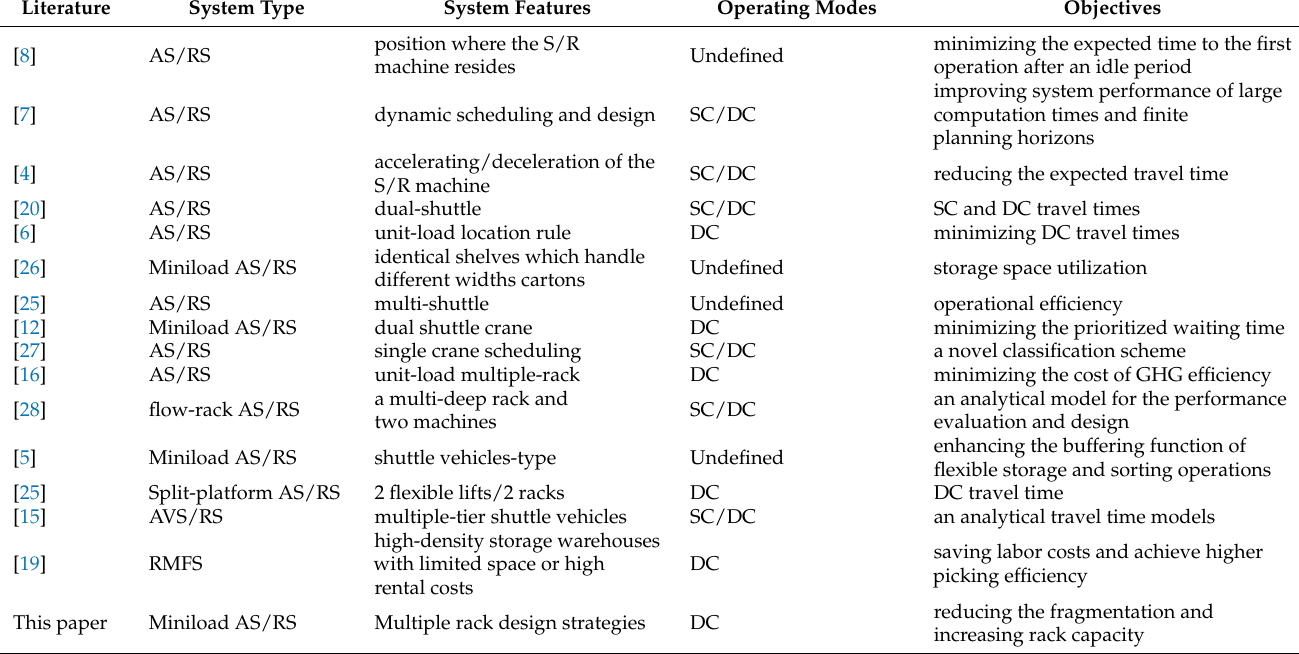
Table 1. The studies of optimization in